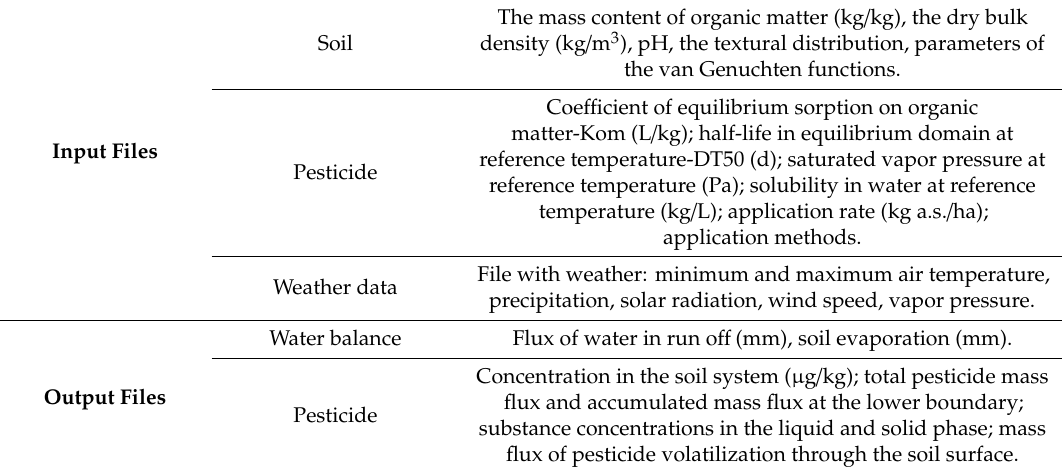
Table 1. Parameters of the PEARL 4.4.4 model.